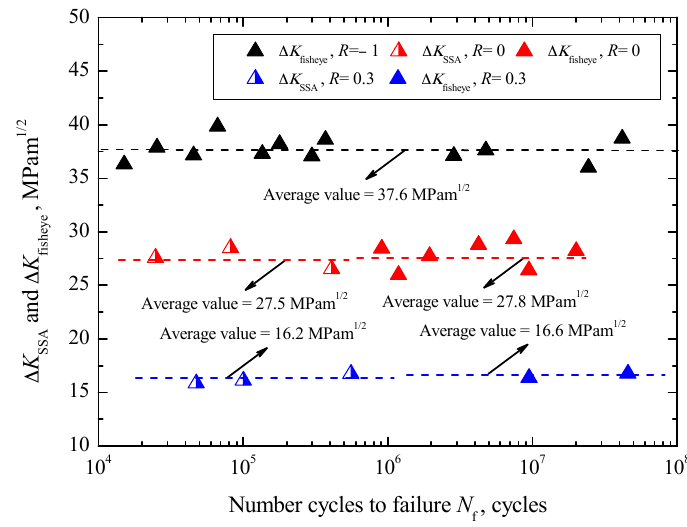
∆ K ∆ K SSA and fisheye , and N f